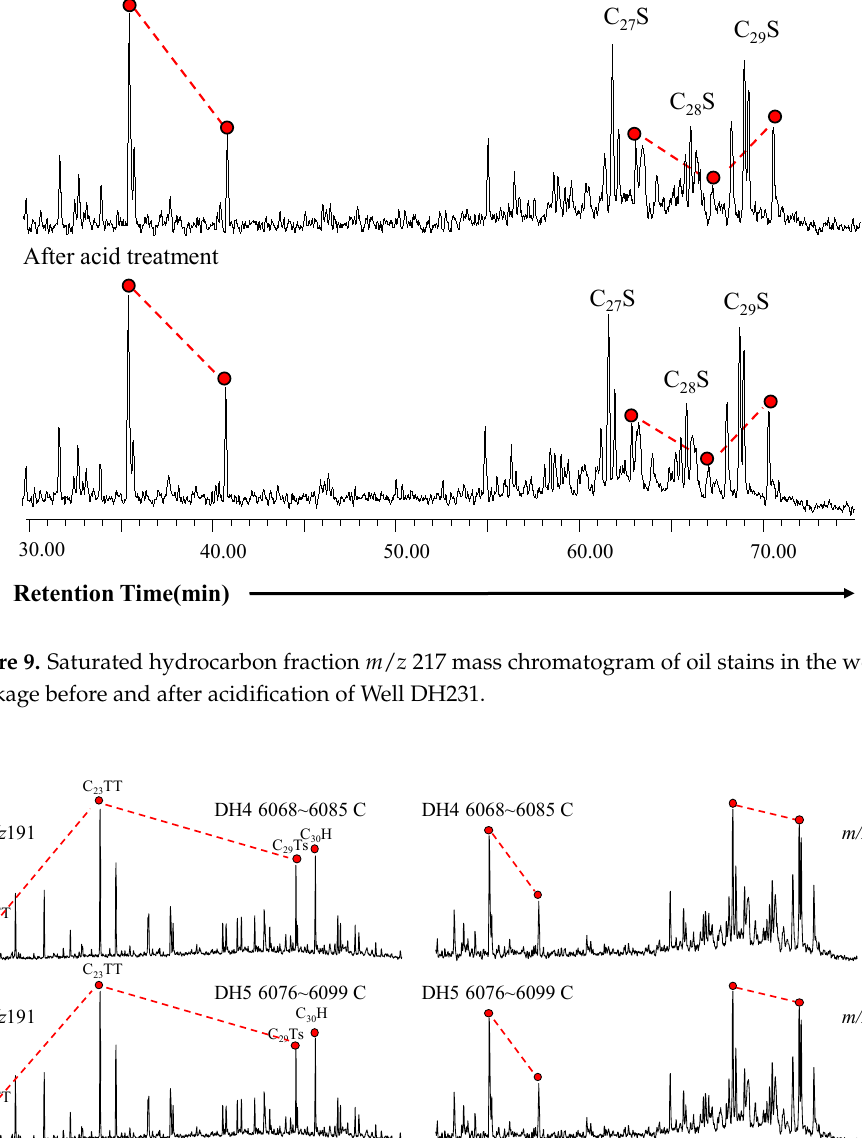
Figure 11. The cross plots of Pr/nC17 and Ph/nC18 of Ordovician crude oil and the wellhead block ‐ age . However, compared to the saturated hydrocarbons of crude oil in Well DH601, there was a significant reduction in the light component of the oil stains (Figure 12). The relative content of nC 15 in the oil stain can be more than 5% lower than that of the crude oil from Well DH601. At the same time, the content of heavy components in the oil stains showed a significant increase again (Figure 12). In summary, the oil stains at the wellhead of Well DH231 may come from the same reservoir system as the crude oil of Wells DH 4 and DH5. The oil stains in the blockage were the migration products of the crude oil in Wells DH 4 and DH5 [46].